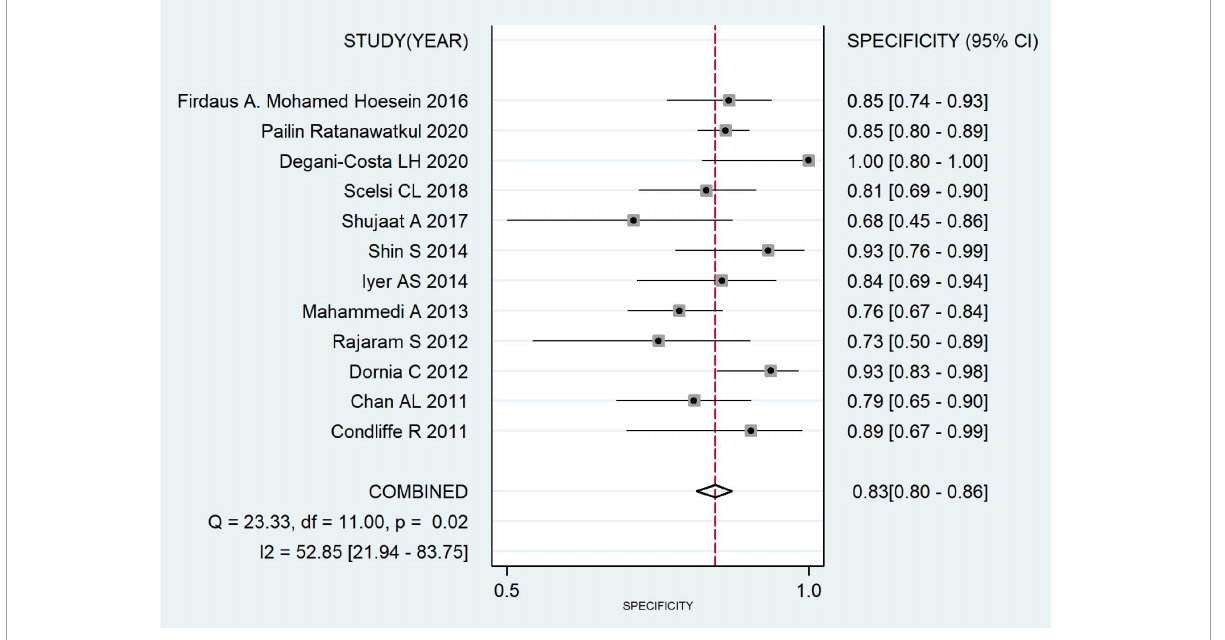
FIGURE4 Forest plot of CT combined sensitivity of pulmonary hypertension.